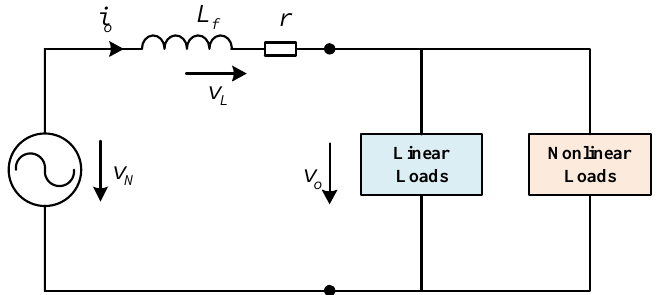
Figure 2. Equivalent circuit of the virtual harmonic impedance